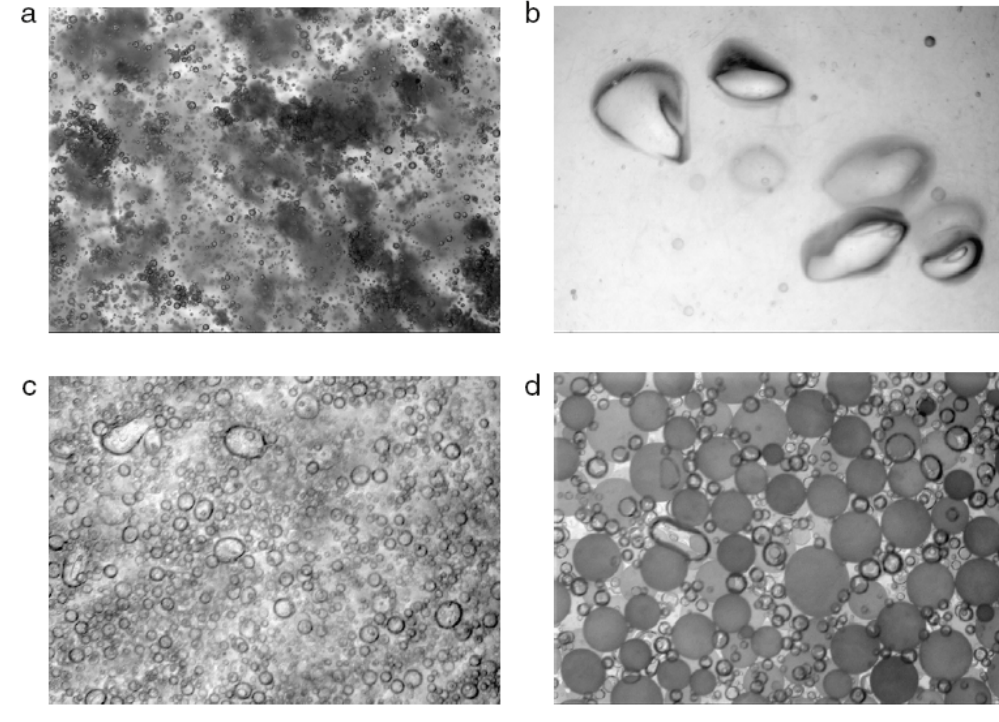
Figure 13. ( a ) Micro-bubbles and flocculate waste particles in an industrial DAF process; ( b ) Bubbles and fibers in a white water de-aeration channel flow; ( c ) Bubbles in the inlet flow of a deinking flotation process; ( d ) Plastic beads and gas bubbles in a plastic bead production reactor